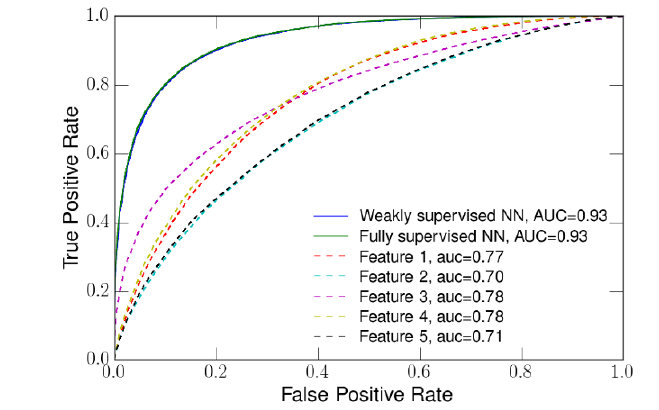
Figure 4 . ROC curves for instance classi(cid:12)cation using (cid:12)ve individual features and then combined using a fully supervised network and the weakly supervised